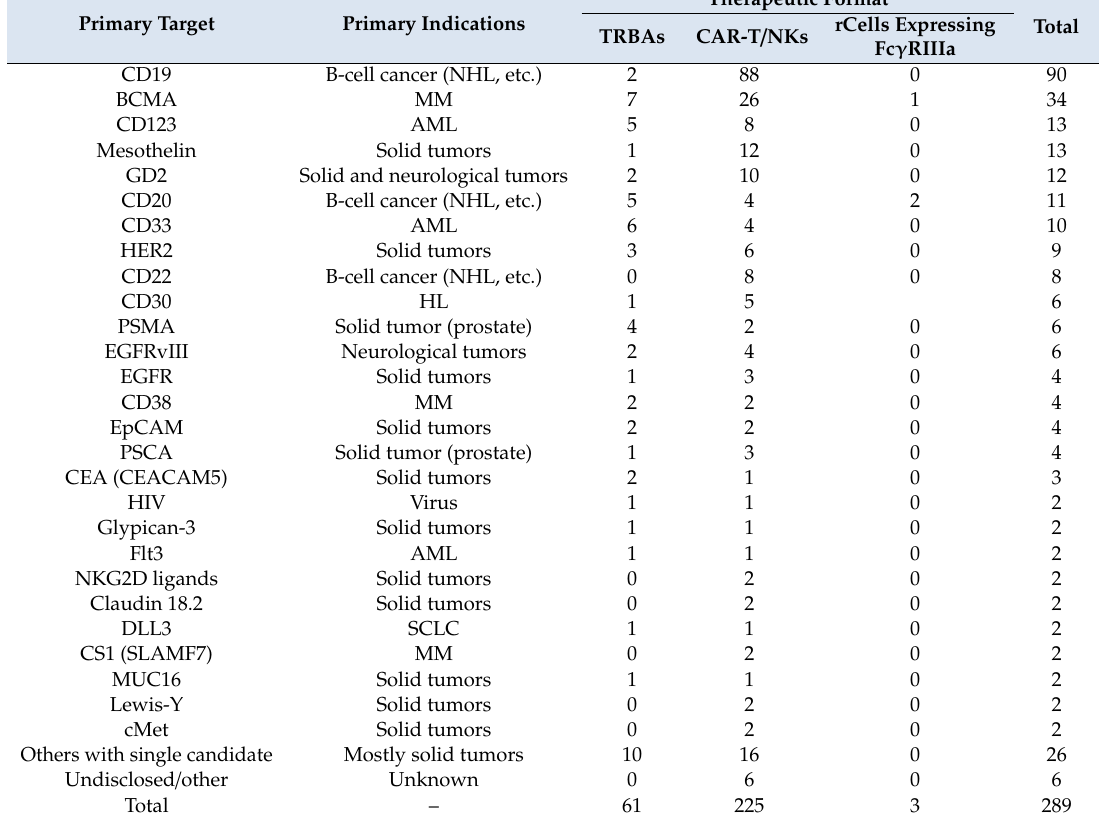
Table 5. Targets of clinical stage T-cell redirected therapeutics, TRBAs and CARs * ,